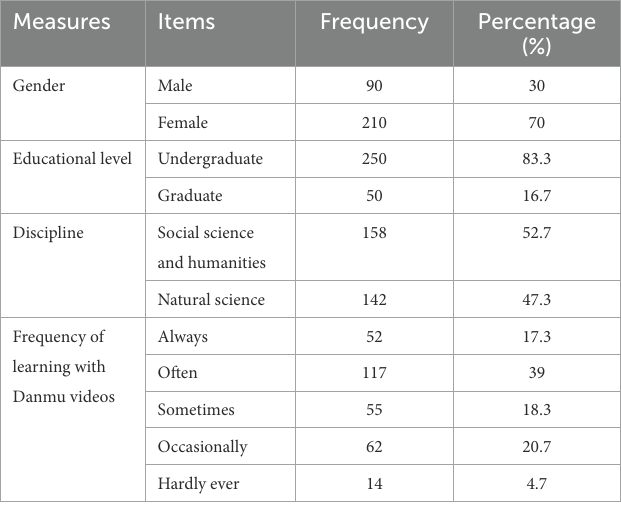
TABLE 1 Demographic statistics of participants ( N =